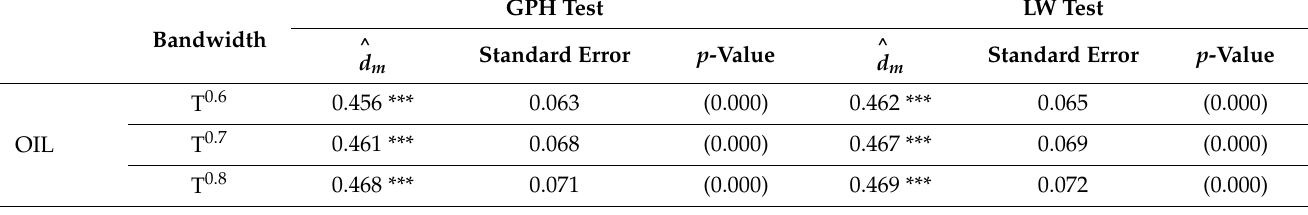
Table 4. GPH and LW tests for squared